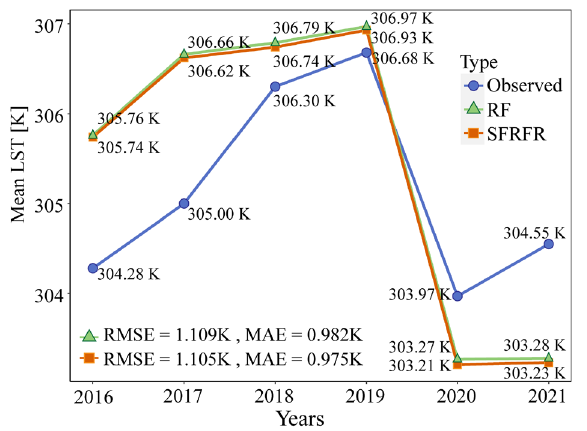
Figure 12. Line chart of the average summertime reconstructed LST and the ground-station-observed LST in the past six years.